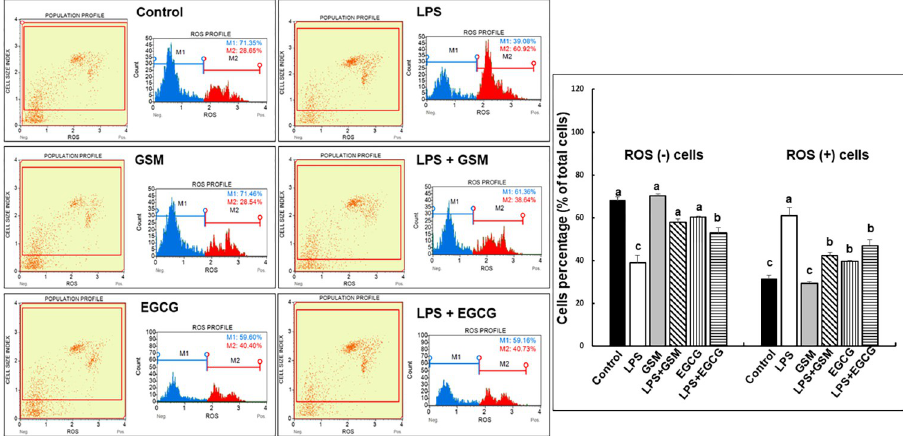
Fig 1. Effects of GSM on the distribution of ROS (+) and ROS (-) cells in IPEC-1 cell population. IPEC-1 cells were incubated with the following treatments for 24 hours: Control = untreated cells; LPS = cells treated with LPS (5 μ g/ml) + 100 μ L culture media, 24h; GSM = cells pre-incubated 4h without LPS and treated after with 100 μ L (50 μ g/mL) of GSM phenolic extract; LPS + GSM = cells pre-incubated with LPS (5 μ g/ml) 4 h and treated after with 100 μ L (50 μ g/ mL) of GSM phenolic extract 24h; EGCG = cells pre-incubated 4h without LPS and treated after with 100 μ L (23 μ g/ ml) EGCG; LPS + EGCG = cells incubated with LPS (5 μ g/ml) 4 h and treated after with 100 μ L (23 μ g/ml) EGCG, 24h. Results are presented as means ± standard errors, from three individual experiments. For each treatment, representative dot plots as well as histograms were presented (left panel). a, b, c = Histograms with unlike superscript letters were significantly different ( p < 0.050). Three replicates per treatment were analysed, and median values of ROS (+) and ROS (-) cell percentages were